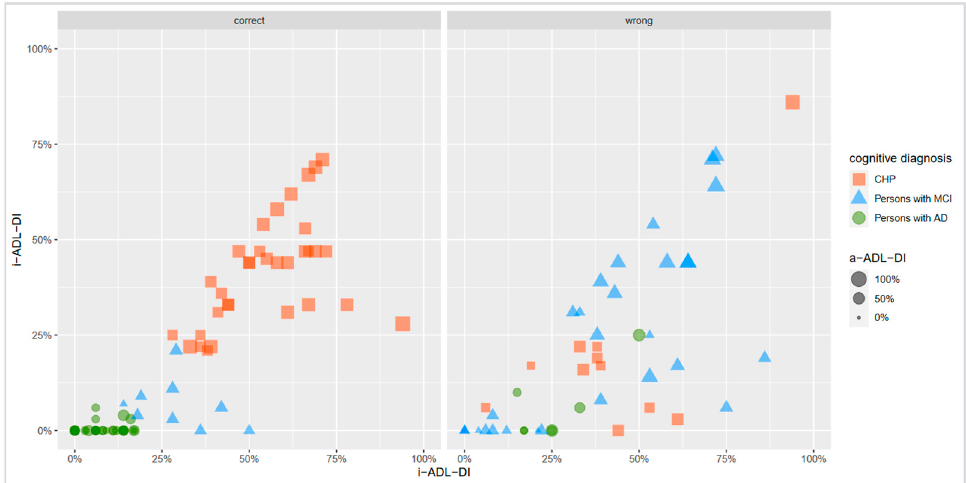
Figure 2. Visualization of the actual BIA data by diagnostic groups . Legend—CHP: Cognitively Healthy Persons; MCI: Mild Cognitive Impairment; AD: Alzheimer’s Dementia; i-ADL-DI: instru- mental Activities of Daily Living Disability Index; a-ADL-DI: advanced Activities of Daily Living Disability Index; i-ADL-CDI: instrumental Activities of Daily Living Cognitive Disability Index.